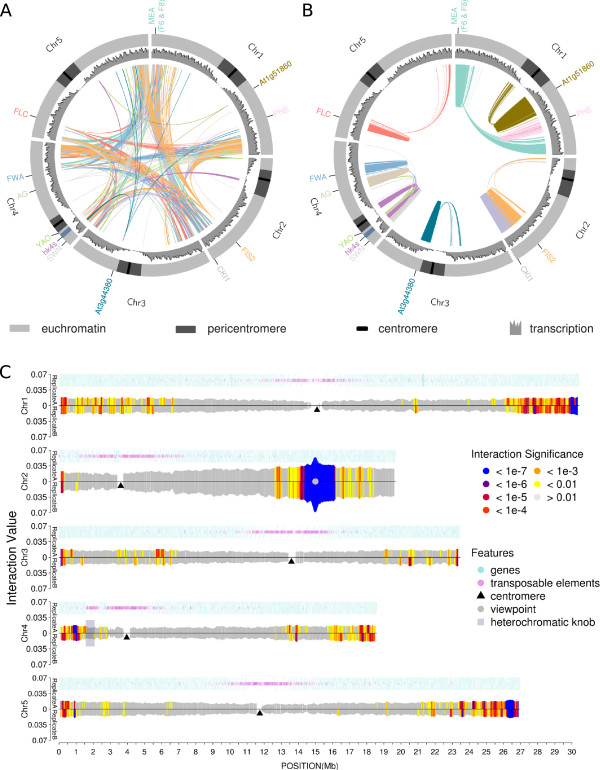
Summary of circular chromosome conformation capture (4C) interactomes. Circos plots illustrate the 4C interactome, transcription rate, and chromosomes with euchromatic and centromeric regions. Line color refers to the color of the viewpoint names at the periphery of the Circos plots. Only interactions with a P < 10-3 are plotted. (A) Trans- interactions; (B) cis interactions; (C) 4C interactome of viewpoint FIS2. Color code refers to significance levels. Gene density (blue circles) and transposable element density (purple circles) are indicated to illustrate the occurrence of heterochromatin and euchromatin. The region covered by the knob hk4s is highlighted with a transparent rectangle on the short arm of chromosome 4. Interaction values equal to ∑i(log2(number of reads in fragmenti)), where i stands for a fragment within a given window, are scaled to the viewpoint’s total library size.